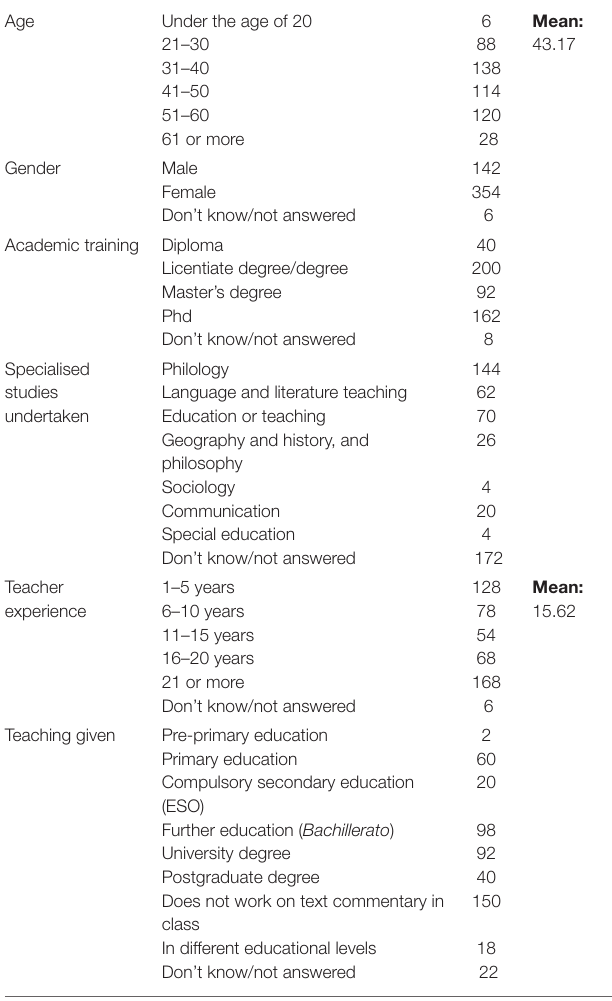
TABLE 3 | Socio-demographic and professional profile of